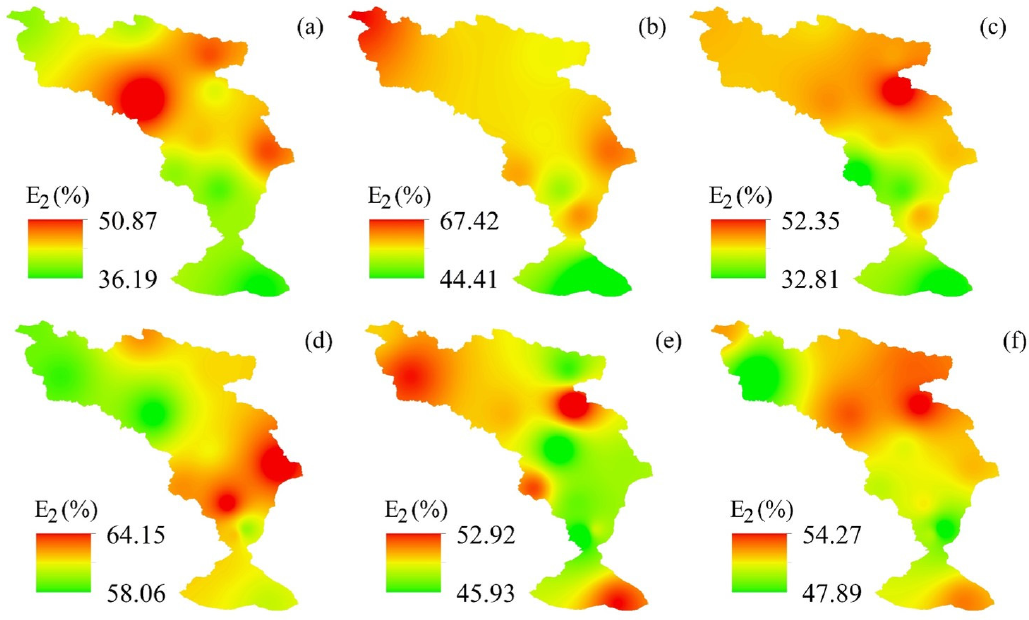
Figure 11. Spatial variation of soil non-evaporated ratio ( E 2 ) in summer 2018 ( a – c ) and 2019 ( d – f ).